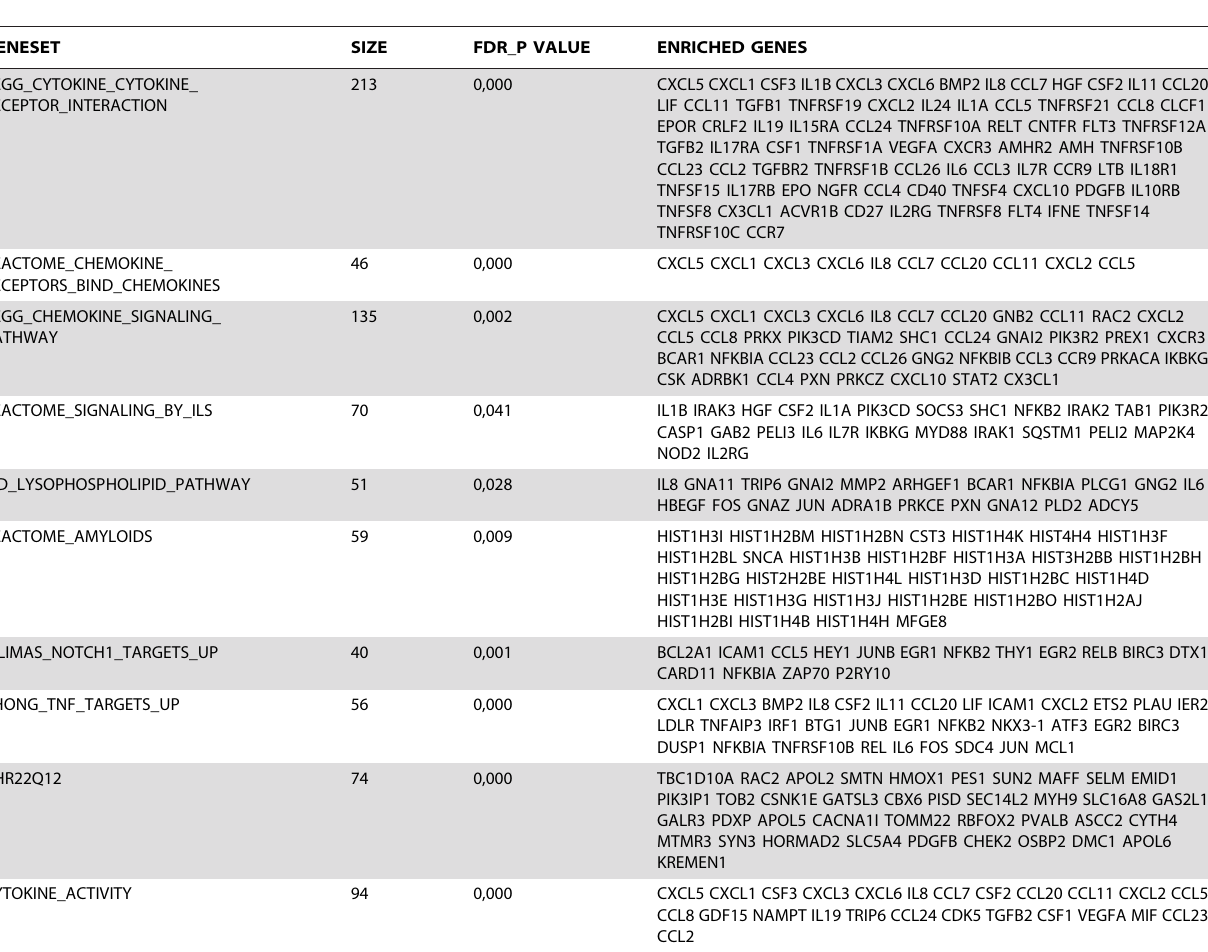
Table 5. Gene Set Enrichment Analysis biological: Pathways significantly associated with ADHLSC and the corresponding FDR as well as the enriched